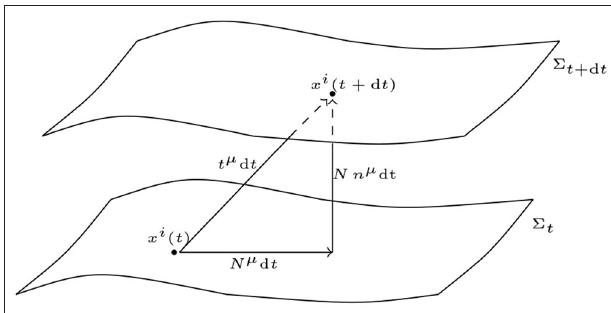
FIGURE 5 | Foliation of D -dimensional spacetime into hypersurfaces of D dimension d 1 at constant time t = −